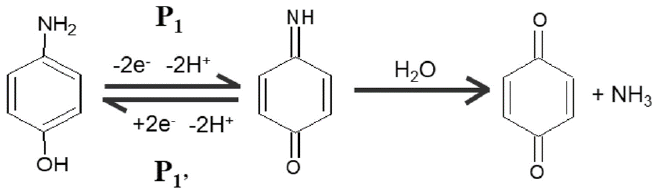
Figure 2. Oxidation of p -AP to quinonimine and quinone [42]. The peak current (I p ) on the voltammogram is inversely related to the p -Ap concentration in the MIP, except at 1.0% (M-4). At 1.5 and 2.0% p -AP (M-5 and M-6), the voltammogram peaks were not clearly observed. SPCE-M_4 resulted in the highest peak current and the most symmetrical voltammogram shape. Based on the data in Table 1, the peak current from M-1 is higher than that of M-2 and M_3. In M-1, there is no p -AP, but there is still cross-linking of chitosan by glutaraldehyde, which forms a cavity; hence, p -AP can pass through to diffuse to the WE surface. In M-2 and M-3, it is possible that there is still p -AP remaining, which was not released during the washing, thus blocking the diffusion of p -AP from the bulk solution to WE during measurement. The p -AP in M-4 is 2 times higher than in M-3; thus, more templates are presumably formed, which then cause the peak current to be higher. However, if there is too much p -AP in the MIP, as in M-5 and M-6, the diffusion is more likely to be blocked.